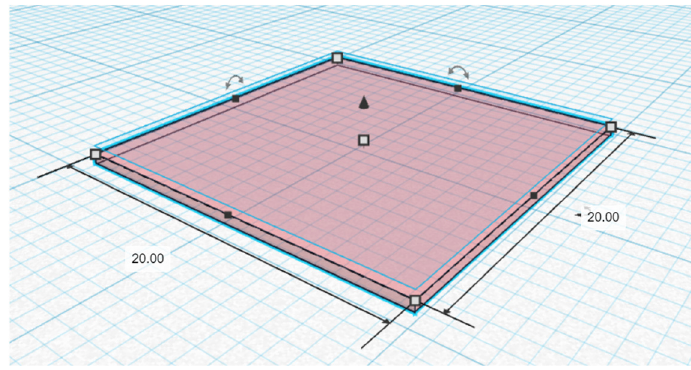
Figure 1. CAD model of the 3D-printed ODF.